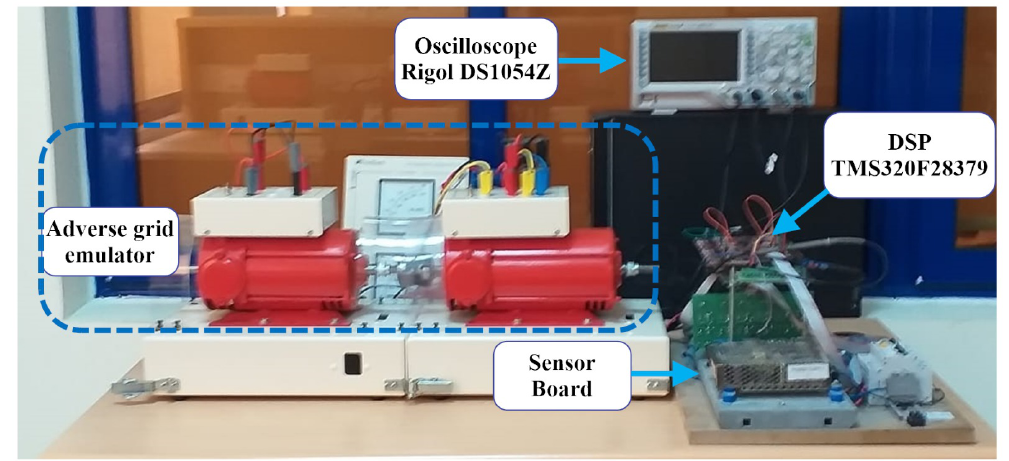
Figure 9. Setup for experimental